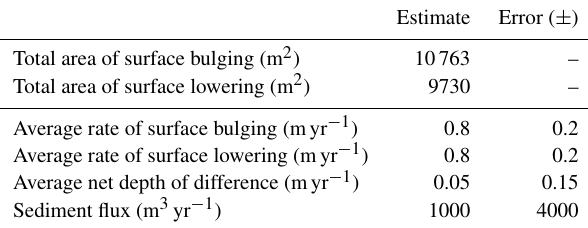
Table 1. Sediment fluxes for the 2014–2015 time interval from the Schimbrig earthflow reported on an annual basis (modified from Clapuyt et al.,